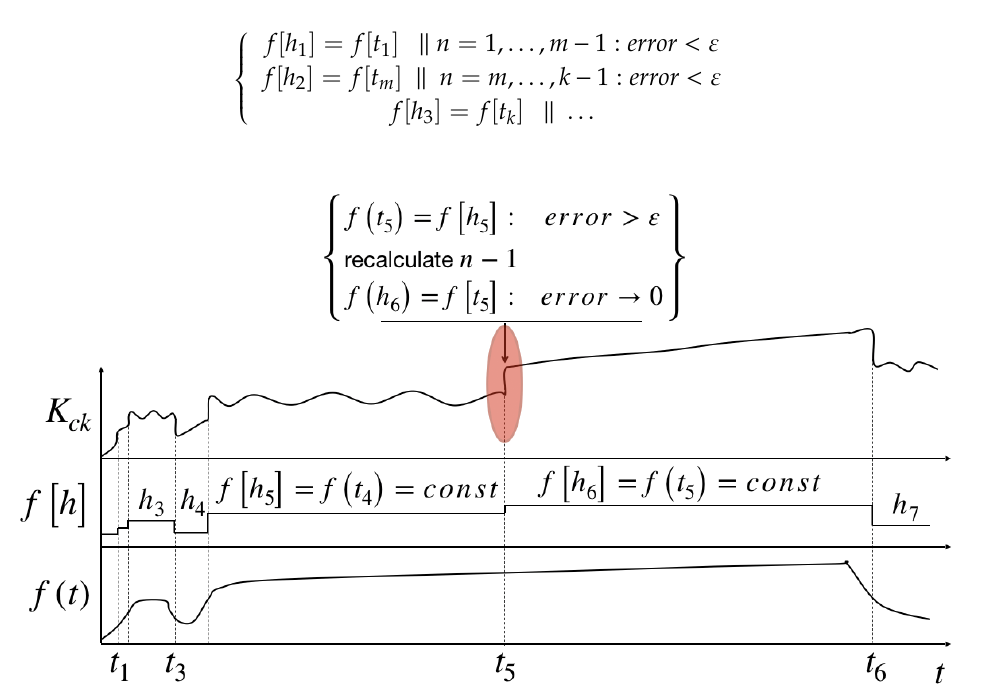
Figure 10. Next step of the simplification based on assumption of using learning techniques by analyzing experimental data.